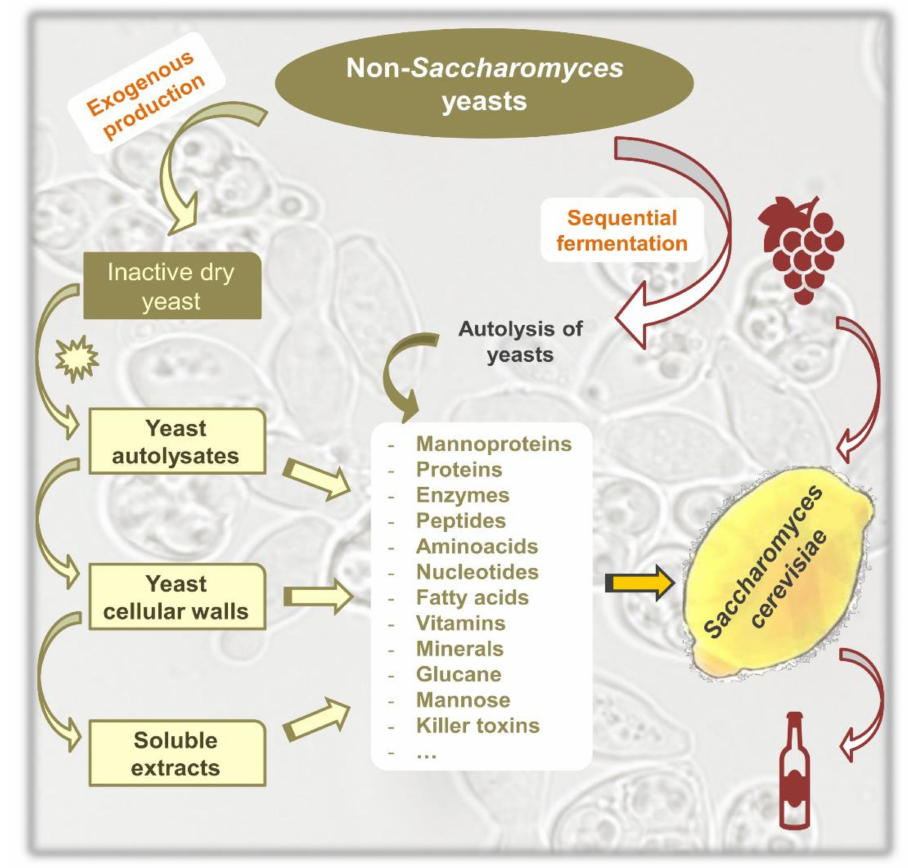
Figure 1. Main cell components of non- Saccharomyces yeasts with the potential for use in wine